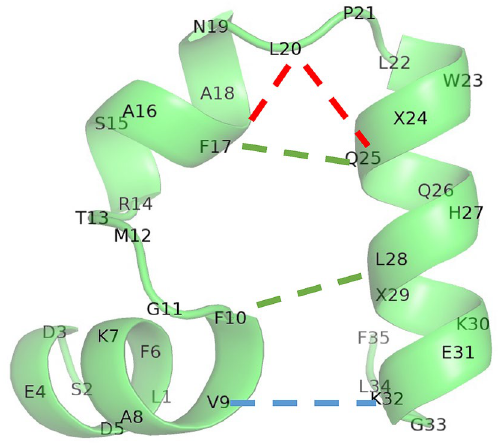
Figure 7. Native state of HP35(nle-nle). Blue, green, and red dashed lines represent the pair whose component was larger than 0.3 in the 1st(blue), 3rd (green), and 4th (red) components obtained by non-negative matrix factorization, respectively. Here, we omitted the pairs inside the α -helices. X represents norleucine.